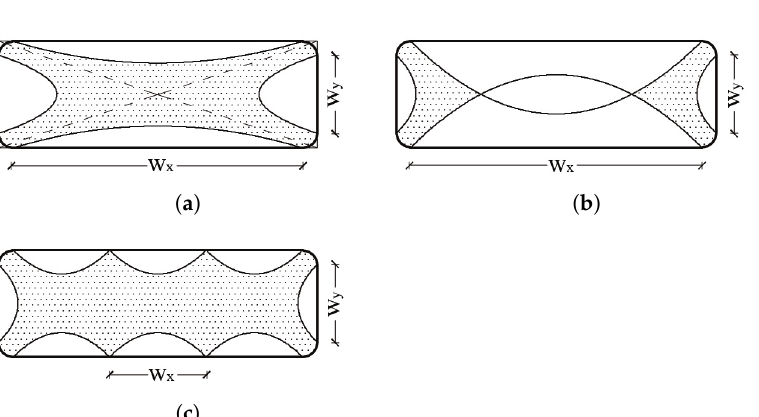
Figure 1. Confinement effect due to transverse fiber: ( a ) Model 1, ( b ) Model 2, and ( c ) Model 3. In Equation (4), α 1 predicts the confined compressive strength in “triaxial” stress state (as in Mander et al. [7]), and α 2 is the parameter that takes into account all the